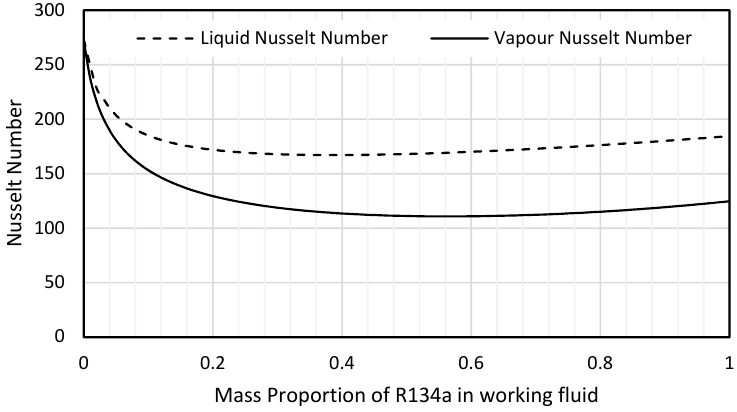
Figure 19. Variation in Nusselt Number in the evaporator for a heat source temperature of 100 °C. It can be seen in Figure 19 that the Nusselt number is around 270 for the pure R245fa, drops to 110 for the vapour Nusselt number and 165 for the liquid Nusselt number. Even for a situation with minimal superheating of the working fluid, this implies that an oversized heat exchanger will be needed for the dynamic cycle compared to a non-dynamic cycle using R245fa as the working fluid. This will add to the capital cost of the dynamic cycle compared to a non-dynamic equivalent.